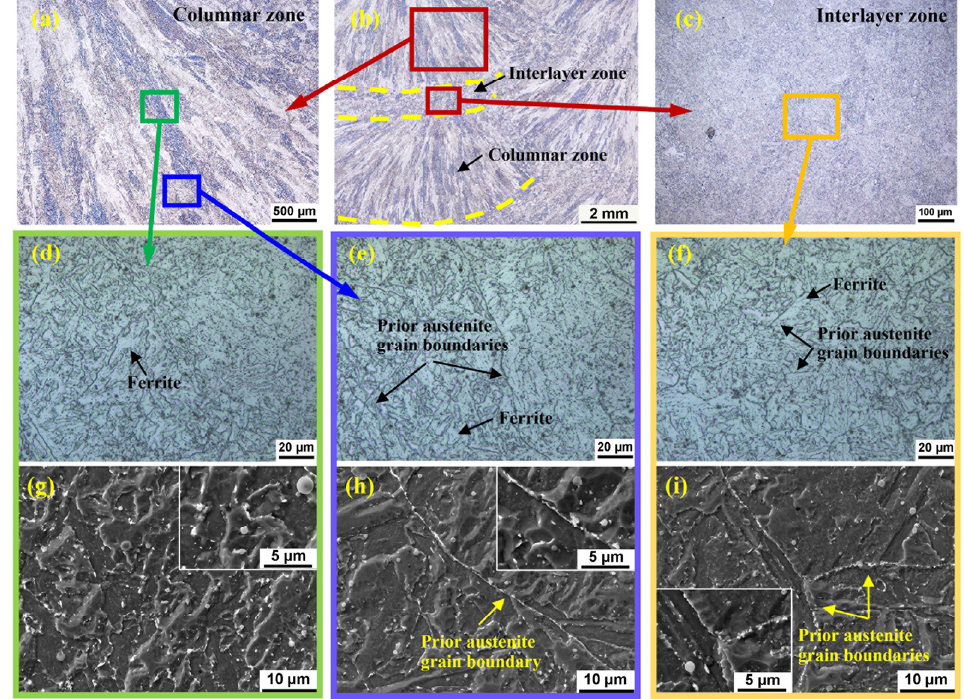
Figure 3. Microstructure of the compressor part WM: ( b ) the entire microstructure of the WM; ( a ) the columnar zone; ( d , g ) the upper part of columnar zone; ( e , h ) the lower part of columnar zone; ( c , f , i ) the interlayer zone.